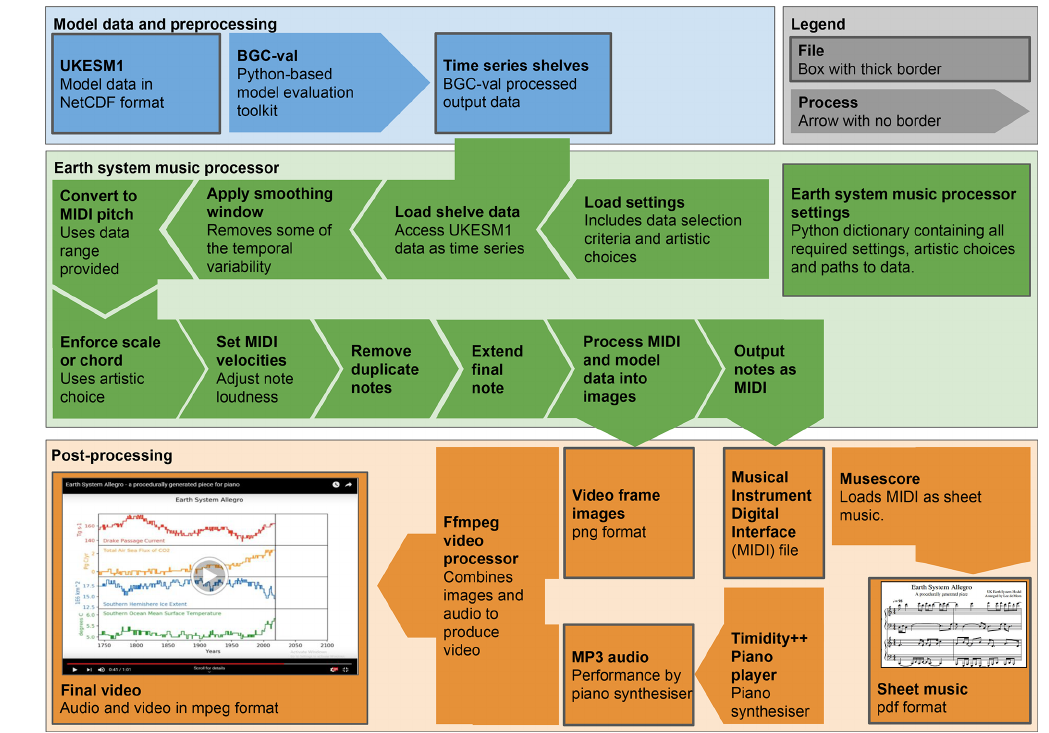
Figure 1. The computational process used to convert UKESM1 data into a musical piece and an associated video. The boxes with a dark border represent files and data sets, and the arrows and chevrons represent processes. The blue areas are UKESM1 data and the preprocessing stages, the green areas show the data and processing stages needed to convert model data into music in the MIDI format, and the orange area shows the post-processing stages which convert images and MIDI into sheet music and